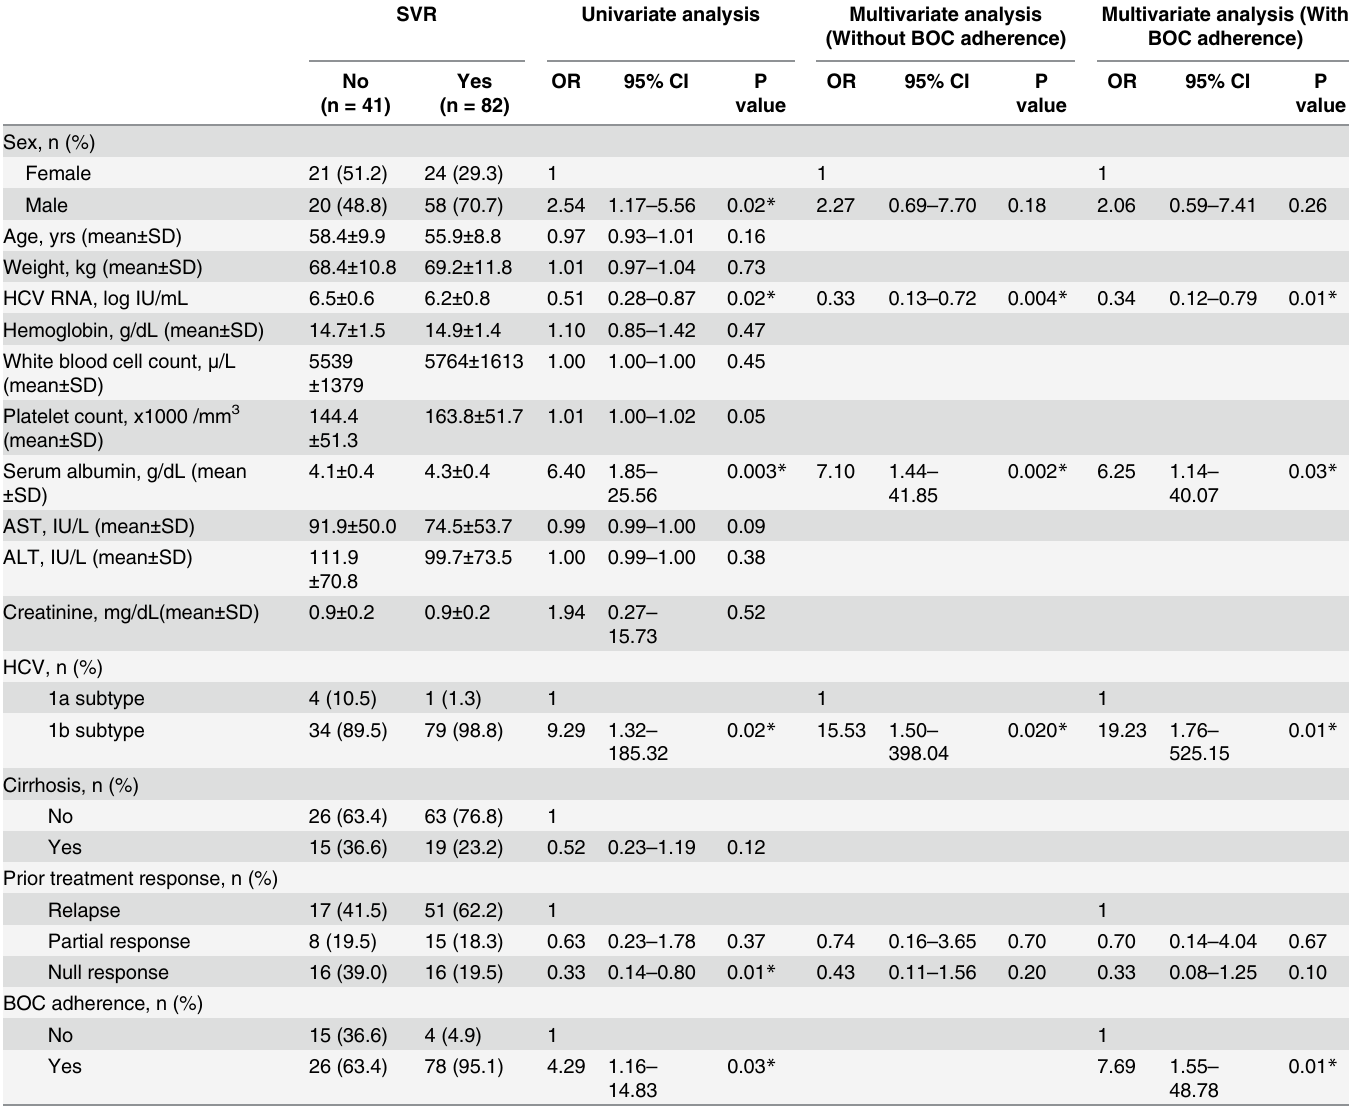
Table 4. Factors associated with SVR. Abbreviations: SVR, sustained virological response; BOC, Boceprevir; RBV, ribavirin; AST, aspartate aminotrans- ferase; ALT, alanine aminotransferase; Ccr, Creatinine clearance rate; OR, odds ratio; CI, confidence intervals. SVR Univariate analysis Multivariate analysis Multivariate analysis (With (Without BOC adherence) BOC